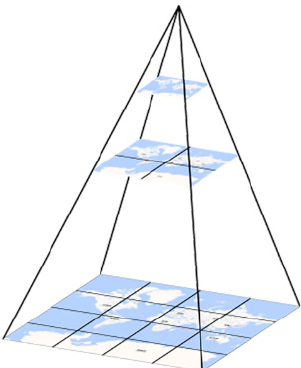
Figure 2. Q-HBML grids’ partition.